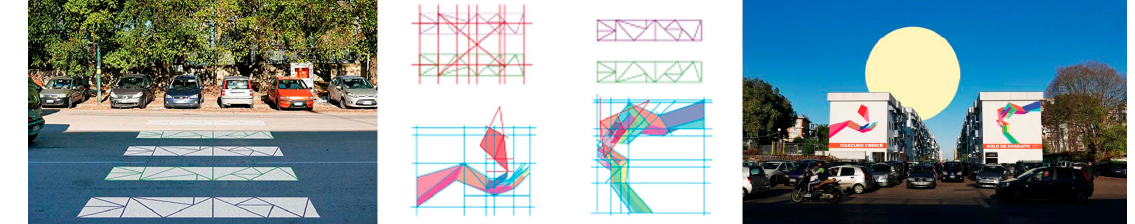
Figure 8. Scampia, Ciascuno cresce solo se sognato (graphic design by Sara